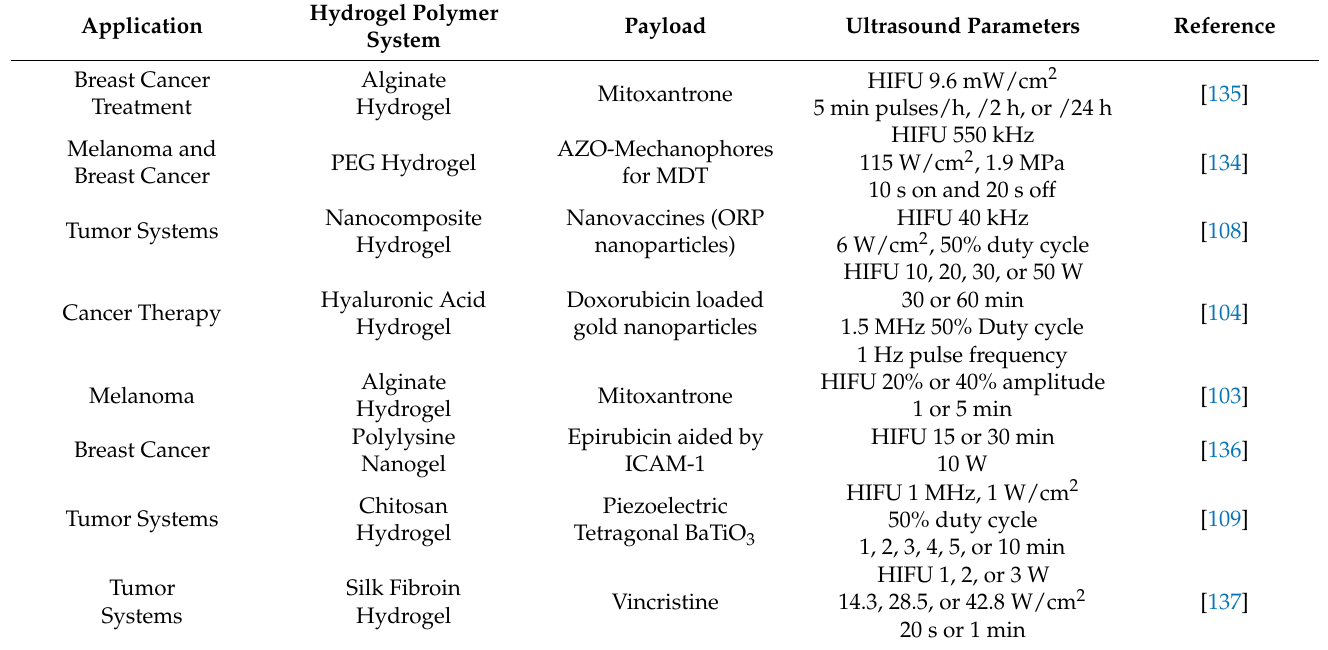
Table 2. Characteristics of hydrogel polymer systems used for cancer therapy.